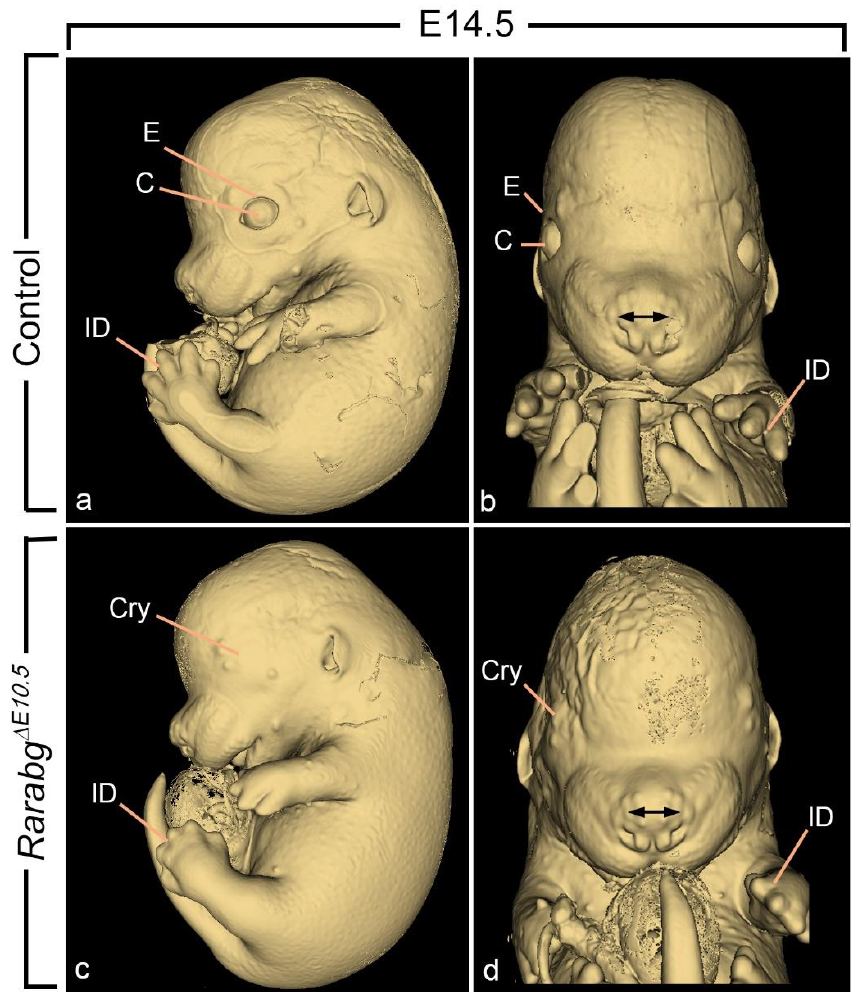
Figure 7. External appearance of control ( a , b ) and Rarabg ΔE10.5 mutant ( b , d ) littermates at E14.5. The cryptophtalmos (Cry), the failure of separation of the digits, and the shortening of the snout are characteristic of the Rarabg ΔE10.5 mutant phenotype (Mark et al., 2021). C, cornea; E, upper eyelid fold; ID, interdigital space. The double arrow indicates the spacing of the nostrils. Same magnifications in ( a , c ) and in ( b , d ).